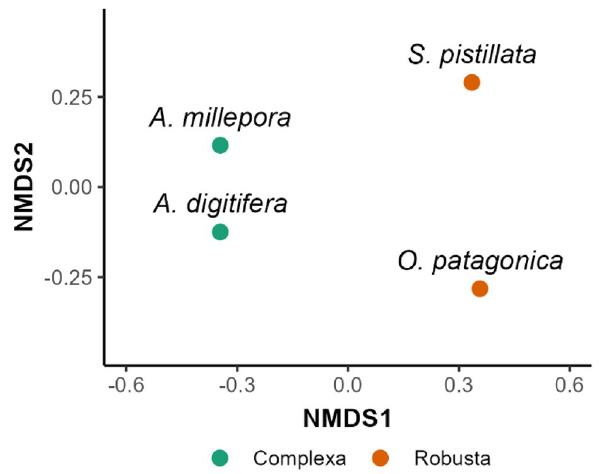
Figure 1. Dissimilarity in composition (Jaccard computed on generic presence-absence) between scleractinian species based on skeletal OM orthologous